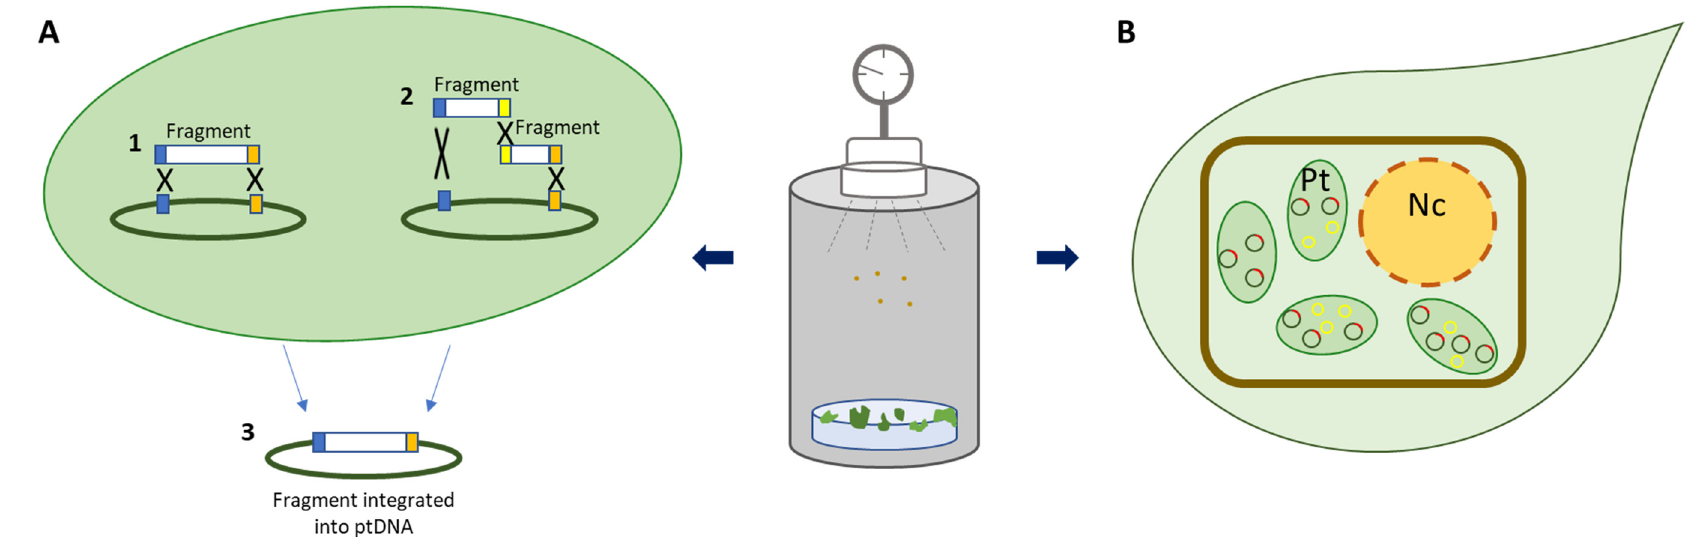
Figure 2. New approaches to express foreign proteins in plastids. ( A ) Fragmented DNA-mediated plastid transformation technology. Transgene may be directly delivered to chloroplast as a single (1) or two fragments (2) by biolistic method. In both cases, integration of transgene is mediated by two (or three) crossover events (3). Blue, yellow and orange boxes are homologous sequences. X indicates homologous recombination events. ( B ) Minichromosome-based approach for chloroplast transformation. Plastid transformation vectors based on geminivirus DNA amplification system were developed and delivered to chloroplast through biolistic method. Minichromosomes are reported as yellow circles; plastid DNA containing rep transgene as green-red circles. Pt = plastids, Nc = nucleus.